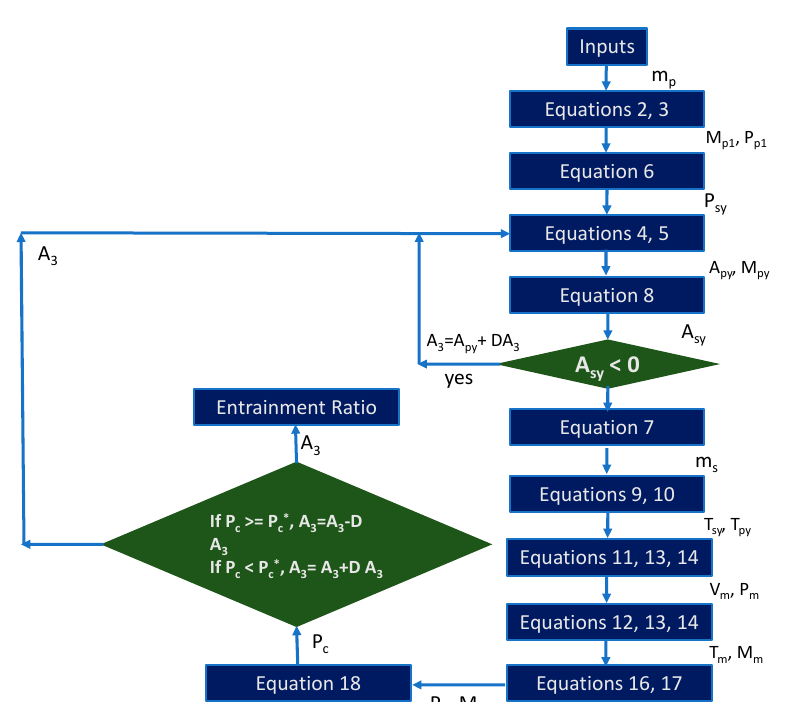
Figure A2. Computation procedure of the 1-D model presented by Huang et al. [34].